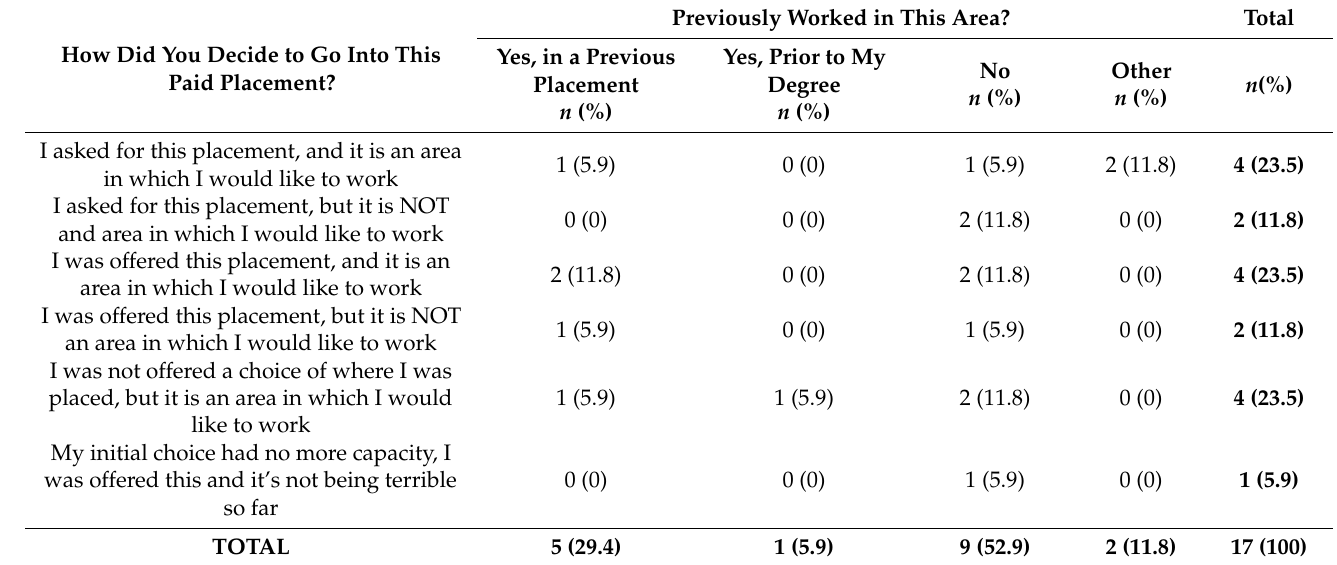
Table 5. Placement decision vs. prior